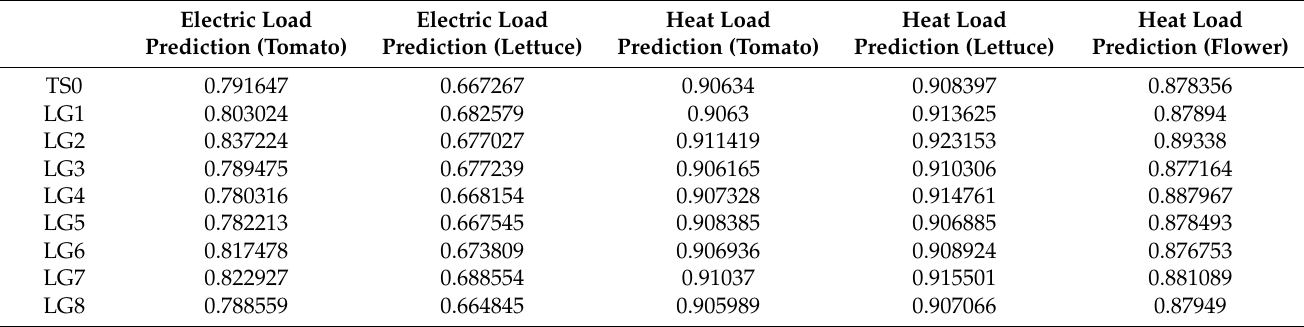
Table 11. The R 2 of each model (logic